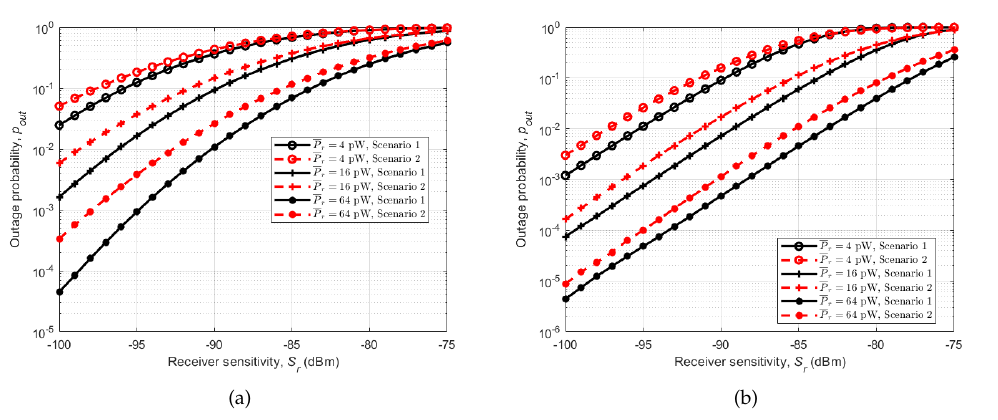
Figure 14. Outage probabilities p out relative to receiver sensitivity S r for different average received power P r . ( a ) running; ( b ) cycling.